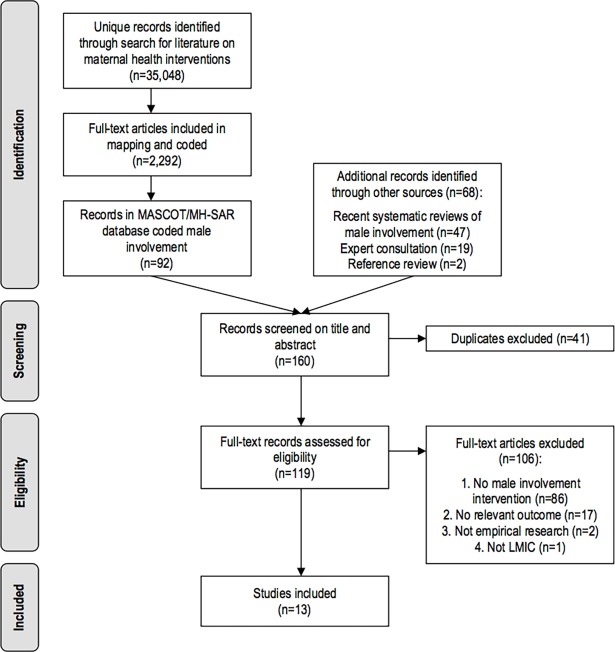
PRISMA flow diagram.